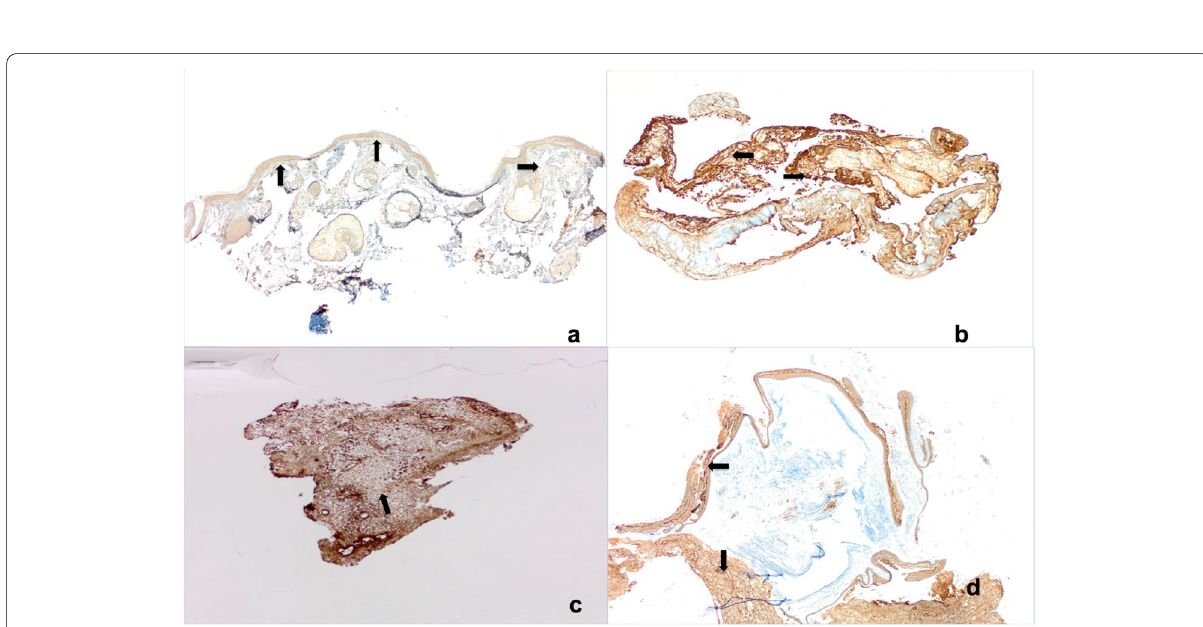
Fig. 2 a Outer ear canal skin (Fibronectin IHK x40): epithelial staining score , stroma . b Avivation tissue (Fibronectin IHK x40): no epithelial + + staining score, stroma . c Granulation tissue (Fibronectin IHK x40): no epithelial staining score, stroma . d Cholesteatoma tissue ++++ +++ (Fibronectin IHK x40): epithelial staining score , stroma +++